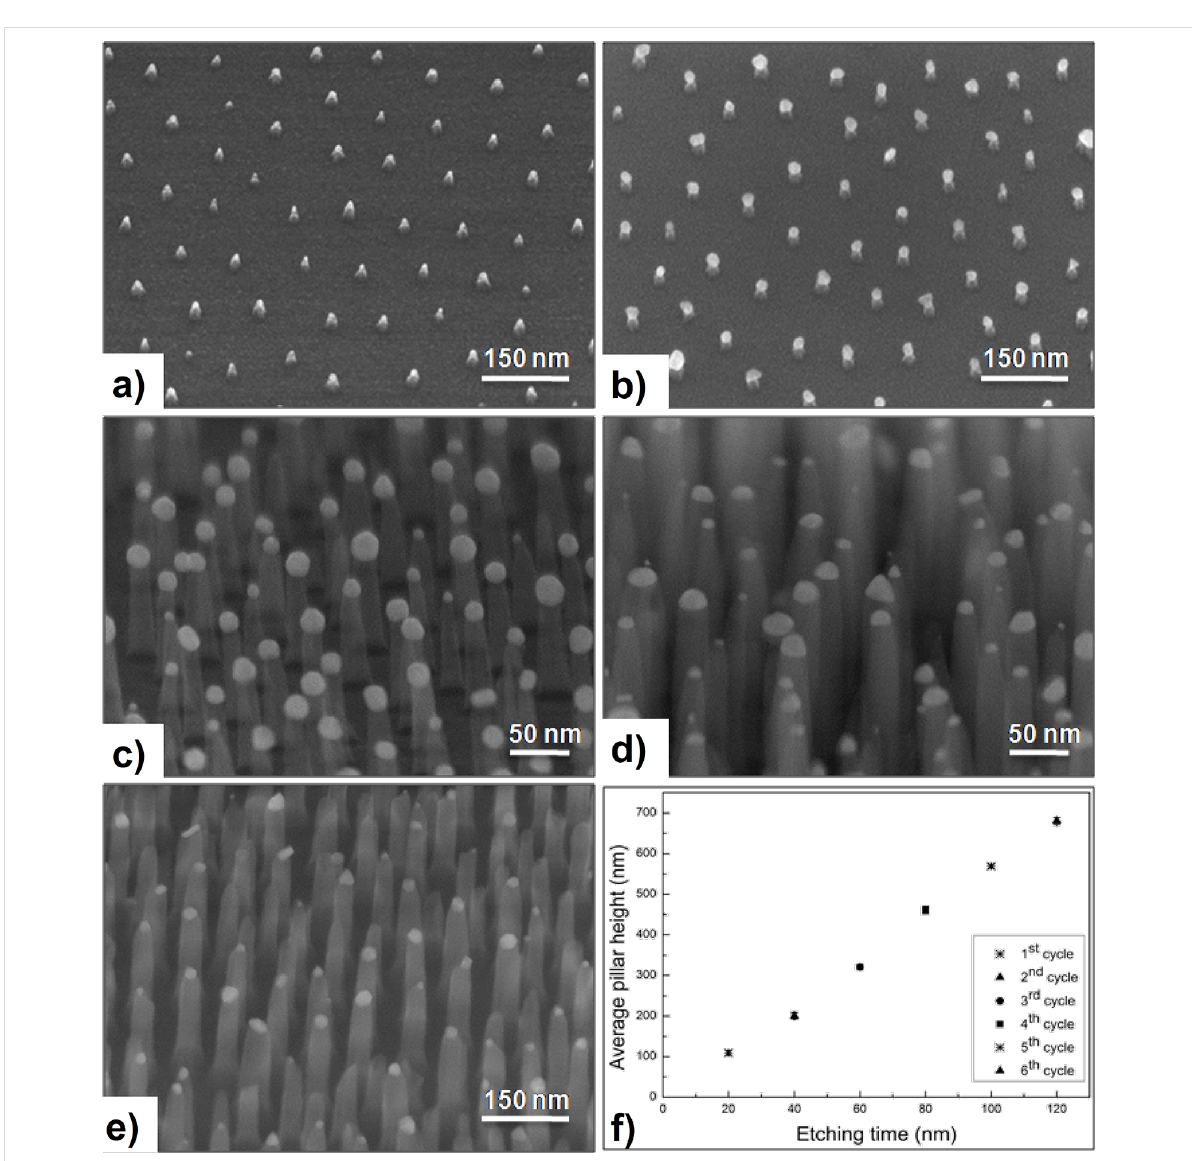
Figure 5: HRSEM images [(a), (b), (e) substrates tilted by 30°, (c), (d) substrates tilted by 80°] of nanopillar arrays with various heights as obtained by the approach outlined in Figure 4. (a) Pillar pattern fabricated on the SiO 2 substrates by a short RIE step [pillar height ( h ) = 25 nm, initial NP diameter = 12 nm, final NP diameter = 9 nm (average values)]. (b) Photochemically grown Au particles on the seeds of panel (a) [final NP diameter = 24 nm (average)]. (c) Seeded Au NP on 100 nm pillars after the 1st etching cycle and (d) residual Au masks after the 2nd etching cycle, pillar height 205 nm (average). (e) Residual Au masks after the 3rd etching cycle, pillar height 320 nm and aspect ratio 8:1 (average). (f) Average pillar height as a func- tion of the total RIE time. Detailed numbers and HRSEM images related to this sequence are given in Figure S3 and Table S1 (Supporting Informa- tion File